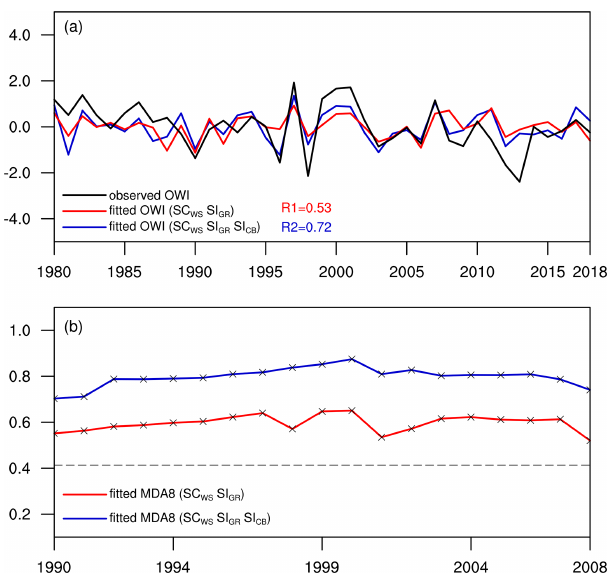
Figure 9. (a) The variation in the JJA-mean observed OWI (black), the fitted OWI-1 (by SC WS and SI GR , red) and the fitted OWI-2 (by SC WS , SI GR and SI CB , blue) from 1980 to 2018 after detrending. (b) The 21-year sliding correlation coefficients between observed OWI and fitted OWI-1 (red) or fitted OWI-2 (blue). The black dotted line (crosses) indicates (exceeded) the 95% confidence